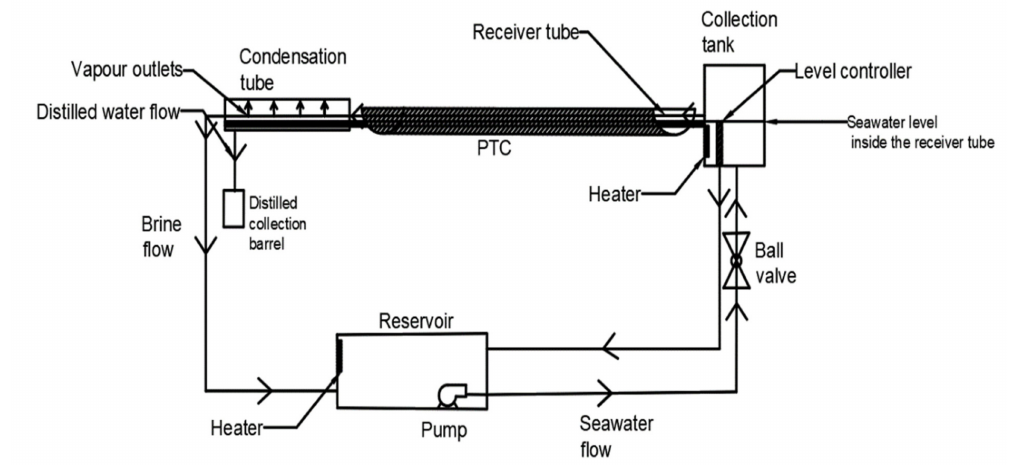
Figure 1. A Schematic presentation the Parabolic Trough Collector (PTC) operation.